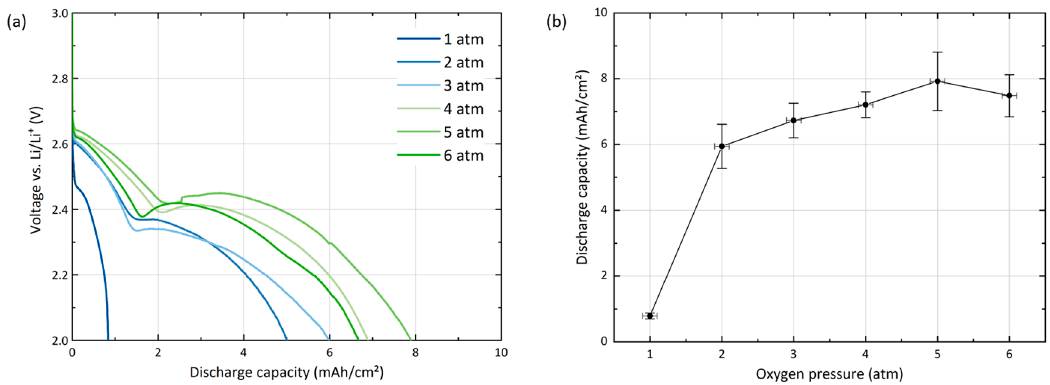
Figure 3. ( a) U ( Q ) profiles of GNS-loaded foam electrodes discharged at 150 µA/cm 2 with oxygen pressures ranging from 1 atm (ambient pressure) to 6 atm. ( b ) Q ( p ) plot with the discharge data of three cells tested at each pressure.